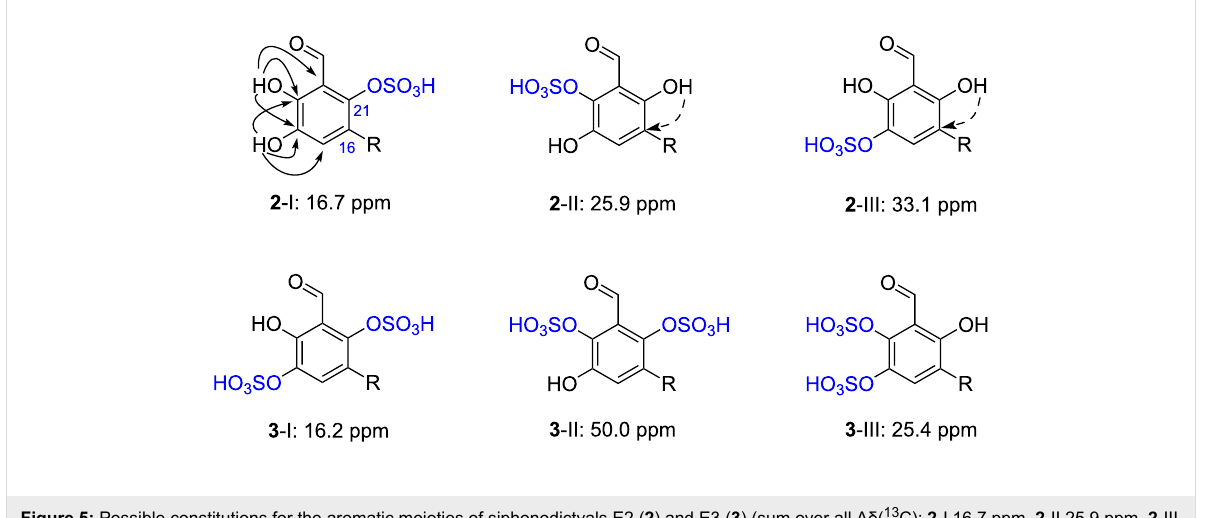
Figure 5: Possible constitutions for the aromatic moieties of siphonodictyals E2 ( 2 ) and E3 ( 3 ) (sum over all Δδ ( 13 C): 2 -I 16.7 ppm, 2 -II 25.9 ppm, 2 -III 33.1 ppm, 3 -I 16.2 ppm, 3 -II 50.0 ppm, 3 -III 25.4 ppm); plain arrows in 2 -I showed the HMBC correlations from 18-OH and 19-OH to the aromatic carbons; dashed arrows in 2 -II and 2 -III indicate HMBC correlations which would be expected.